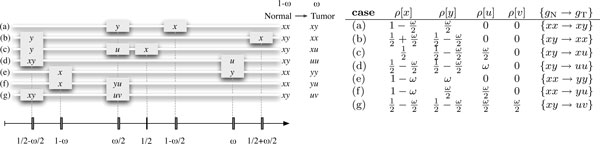
Allele frequencies with impure normal-tumor genotypes that differ from each other. Reads sample the tumor with probability ω, and the normal genotype with 1 - ω.